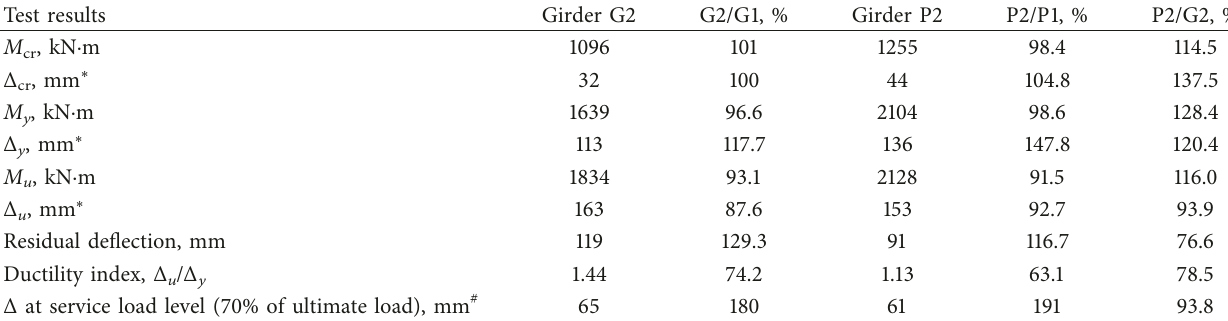
Table 6: Summary of test results for girders G2 and P2.